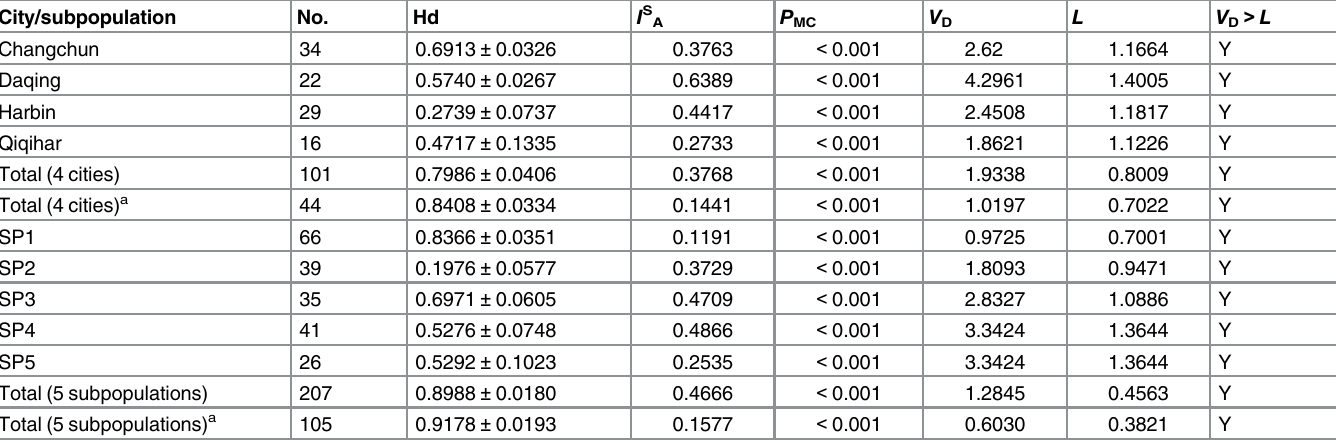
Hd: mean genetic diversity; I S A : standardized index of association calculated using the program LIAN 3.5; P MC : signi fi cance for obtaining this value in 1000 simulations using the Monte Carlo method; V D : variance of pairwise differences; L : 95% critical value for V D ; V D > L indicates linkage disequilibrium. a Considering isolates with the same MLG as one